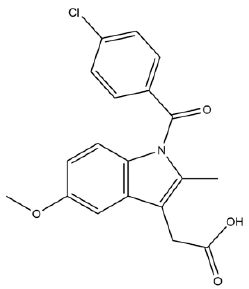
Figure 1. Chemical structures of pure indomethacin.